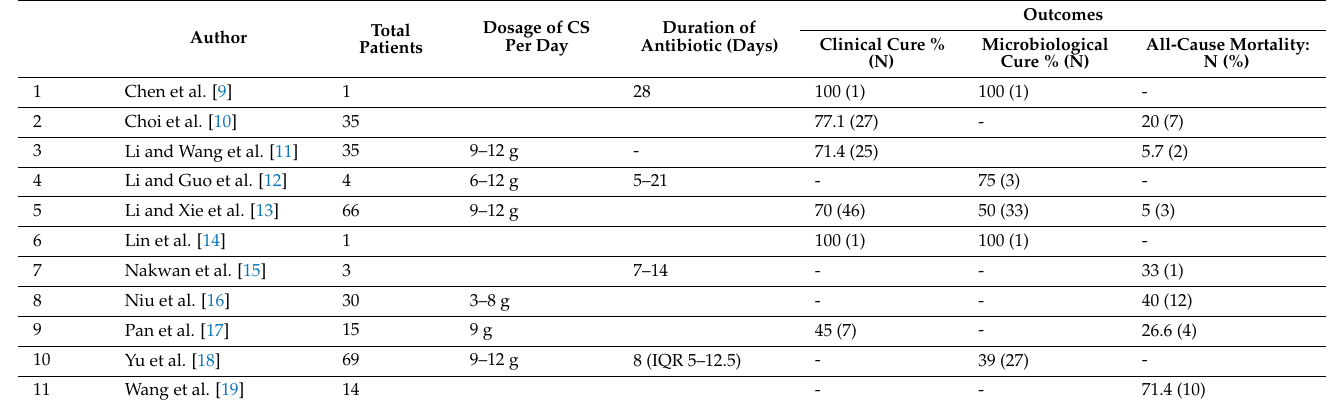
Table 4. Outcomes of patients in whom cefoperazone-sulbactam was used alone.